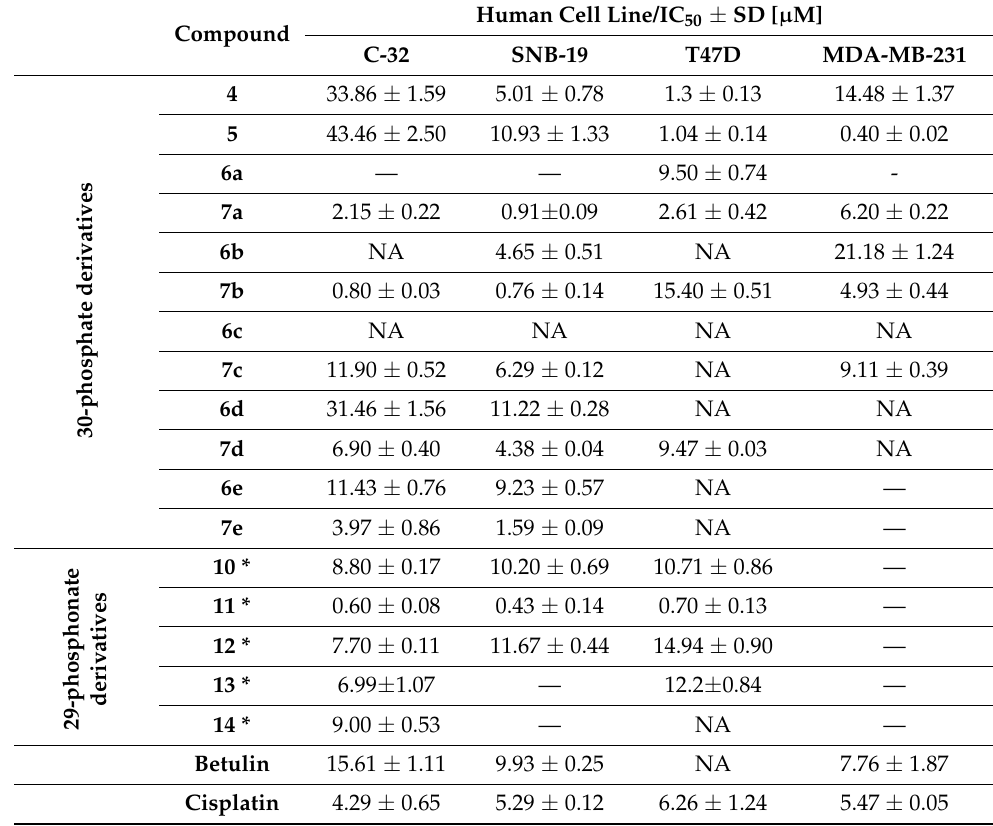
Table 4. Effect of 30-phosphate derivatives of betulin and reference compounds (betulin and cisplatin) on the viability of cells from four cancer cell lines